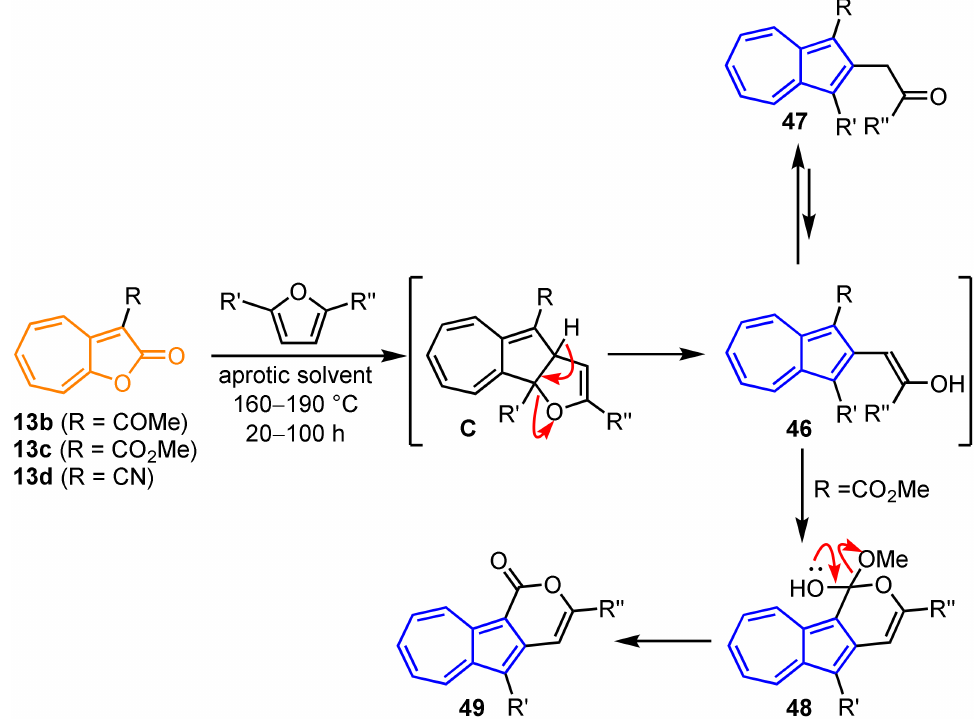
Scheme 16. Synthesis of azulene derivatives 47 and 49 by the reaction of 2 H -cyclohepta[ b